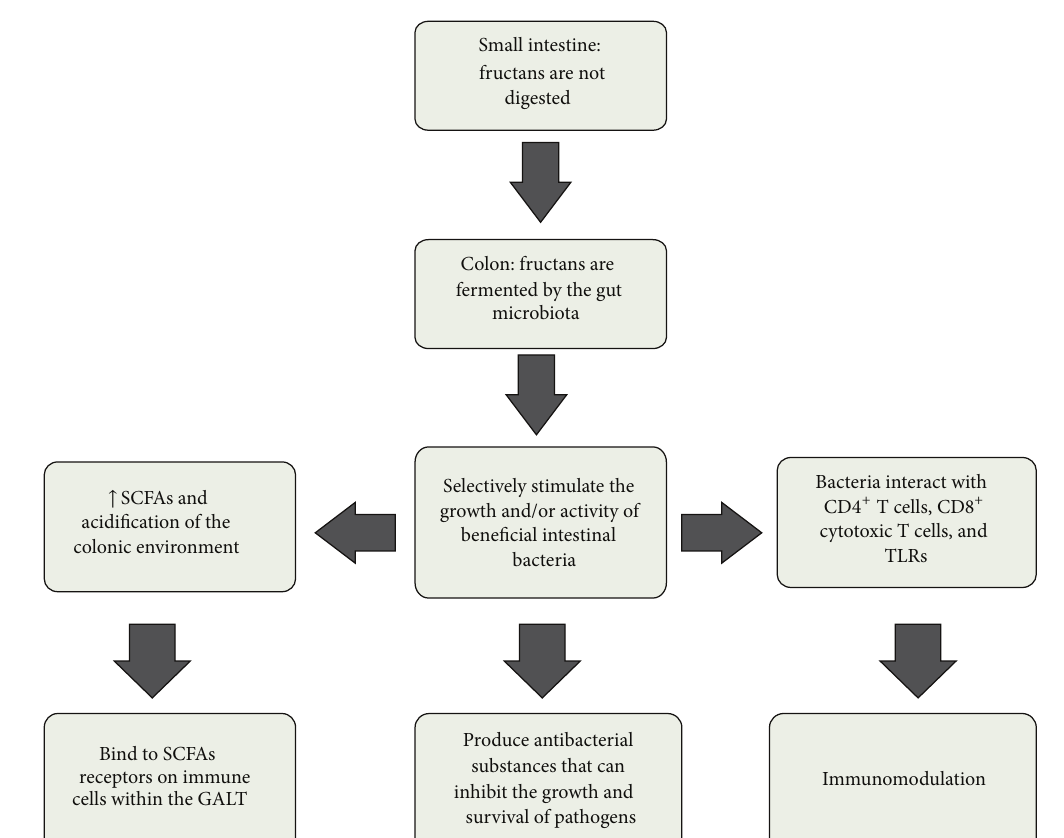
Figure 3: Mechanism for the indirect effect of fructans on the immune